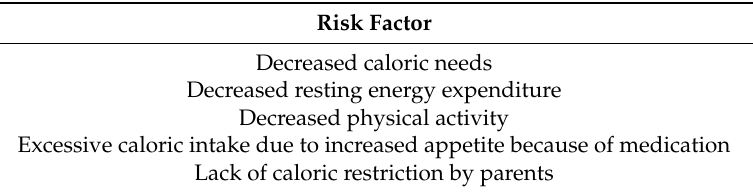
Table 1. Overnutrition in patients with neuromuscular diseases